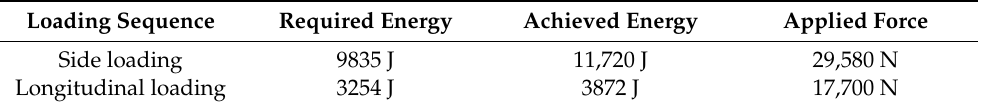
Table 5. Energy and force values applied according to the provisions of the ISO 12117 standard. Loading